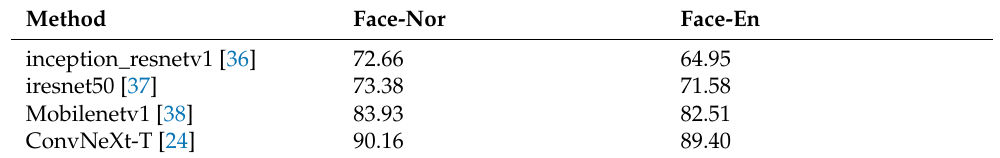
Table 1. Face verification comparison (%) on Face-Nor and Face-En when using different backbones.